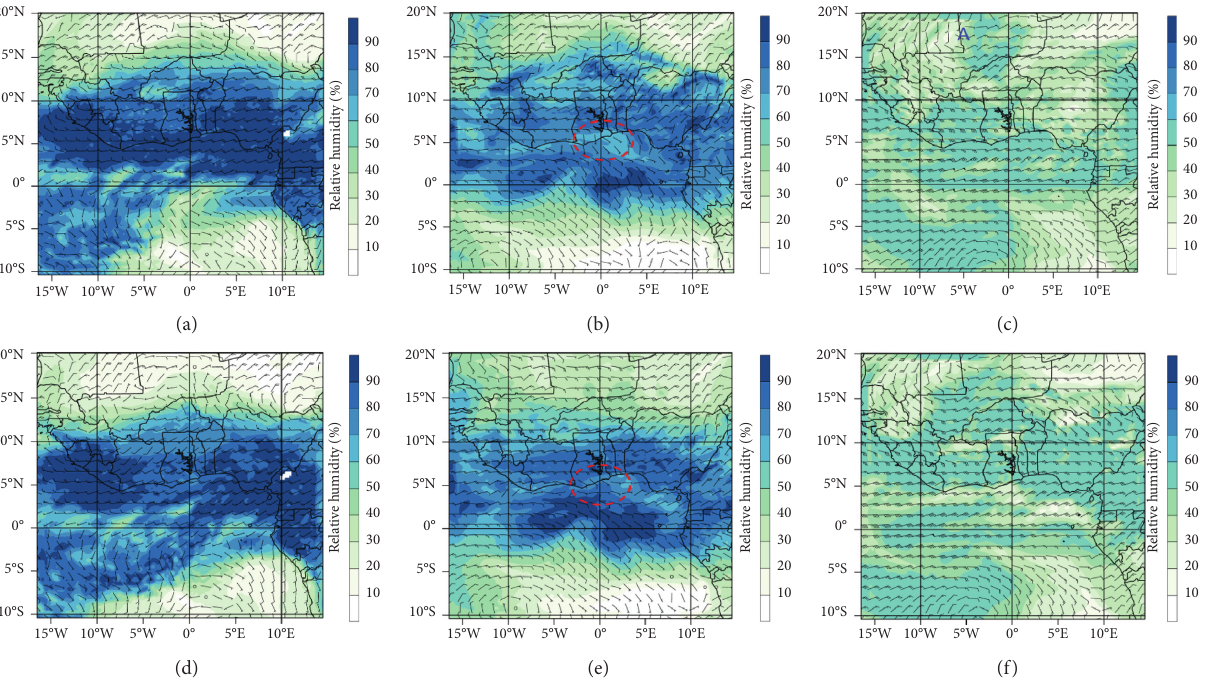
Figure 12: WRF wind speed and direction. For 850hPa, 700hPa, and 200hPa at 12 UTC ((a), (b), and (c)) and 18 UTC ((d), (e), and (f)) for case